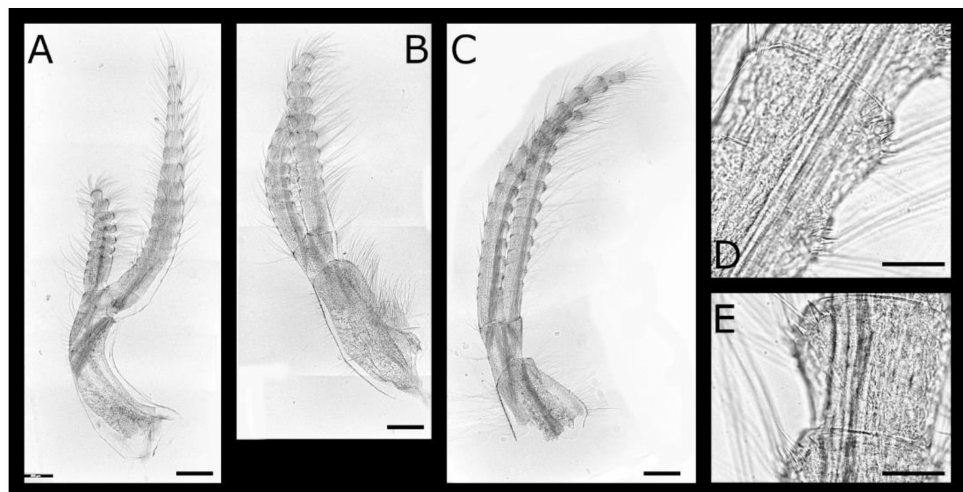
Figure 3. Acasta caveata sp. nov. cirri I–III (all WAM C67716, holotype). ( A ) left cirrus I; ( B ) left cirrus II; ( C ) left cirrus III; ( D ) anterior margin of medial segments of left cirrus III anterior ramus; ( E ) anterior margin of medial segments of right cirrus III anterior ramus. Scale bars: A–C = 200 µ m, D–E = 50 µ m.